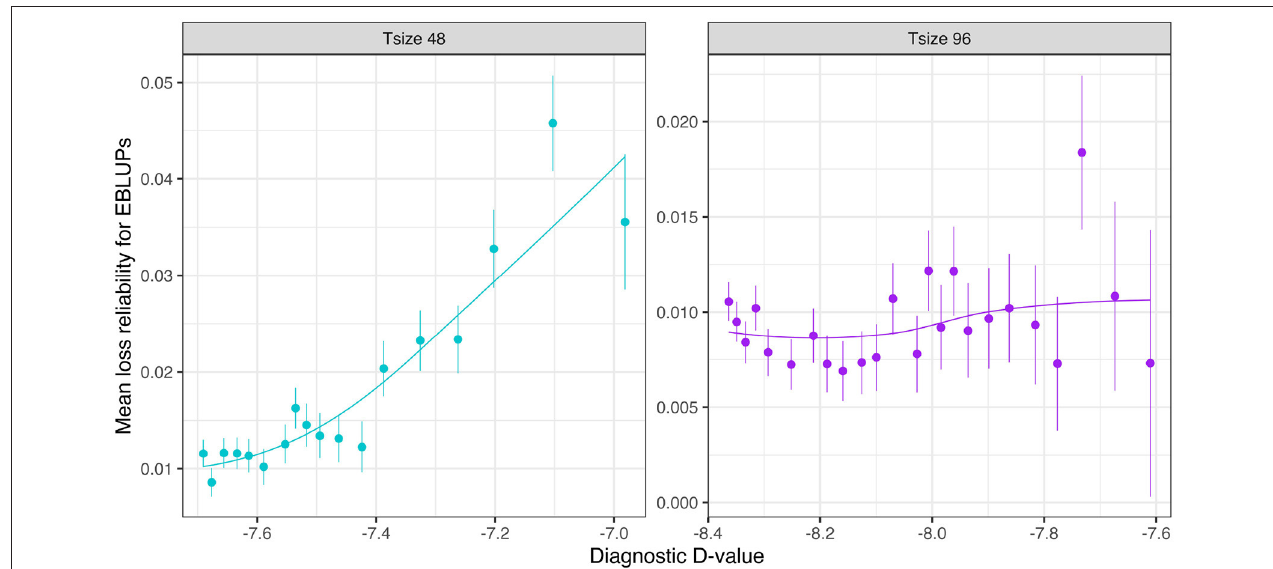
FIGURE 10 | Additive VE effects simulation study: Mean loss in reliability of the EBLUPs of VE effects for Env1 for those varieties that were present in both environments. Each panel corresponds to a different trial size (trials with 48 and 96 varieties) and the points correspond to a sequence of connectivity levels. Also shown are standard errors for each mean (vertical lines) and a loess smoother through the means for each